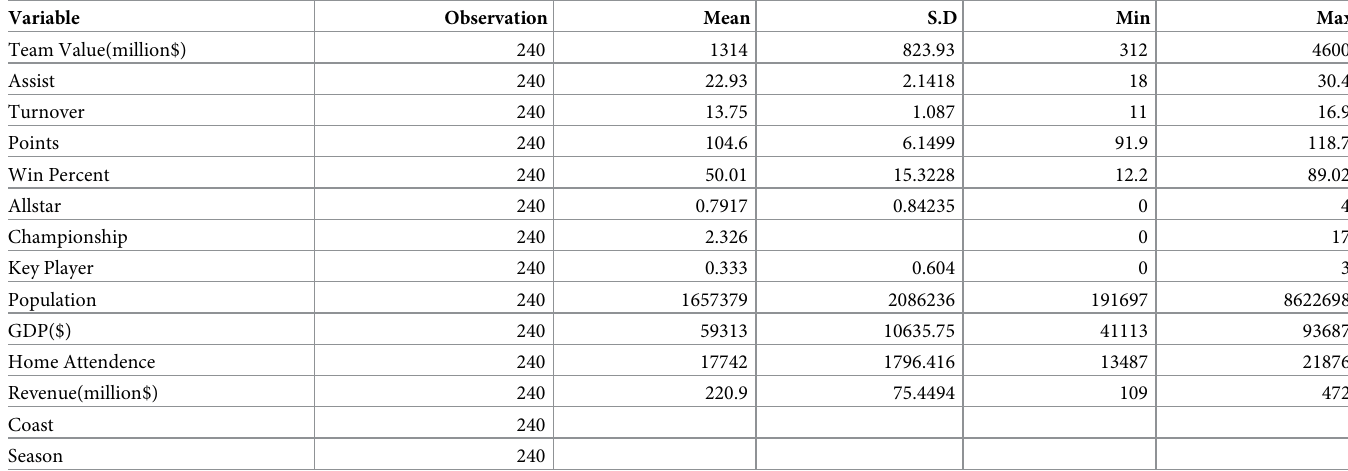
Table 3. Summary of the